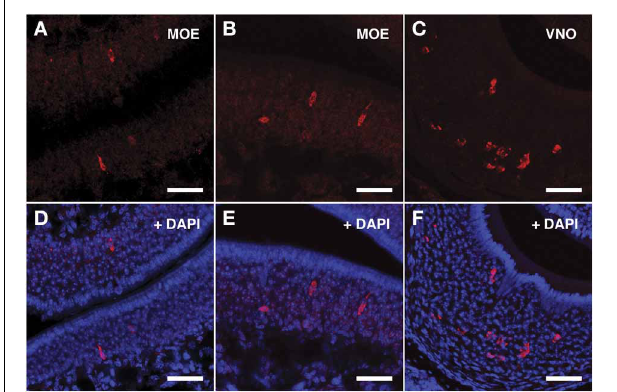
FIGURE 5 | In situ hybridization with Vmn2r69 riboprobes on serial sections of the MOE. (A,B) Cells detected with the Vmn2r69 riboprobe reside in the middle layer of the MOE, and are mostly found in dorsal turbinates. (C) The Vmn2r69 antisense riboprobe hybridizes with a high number of cells in the VNO. (D–F) Panels (A–C) merged with stained nuclei (DAPI). Scale bars: 60 μ m.